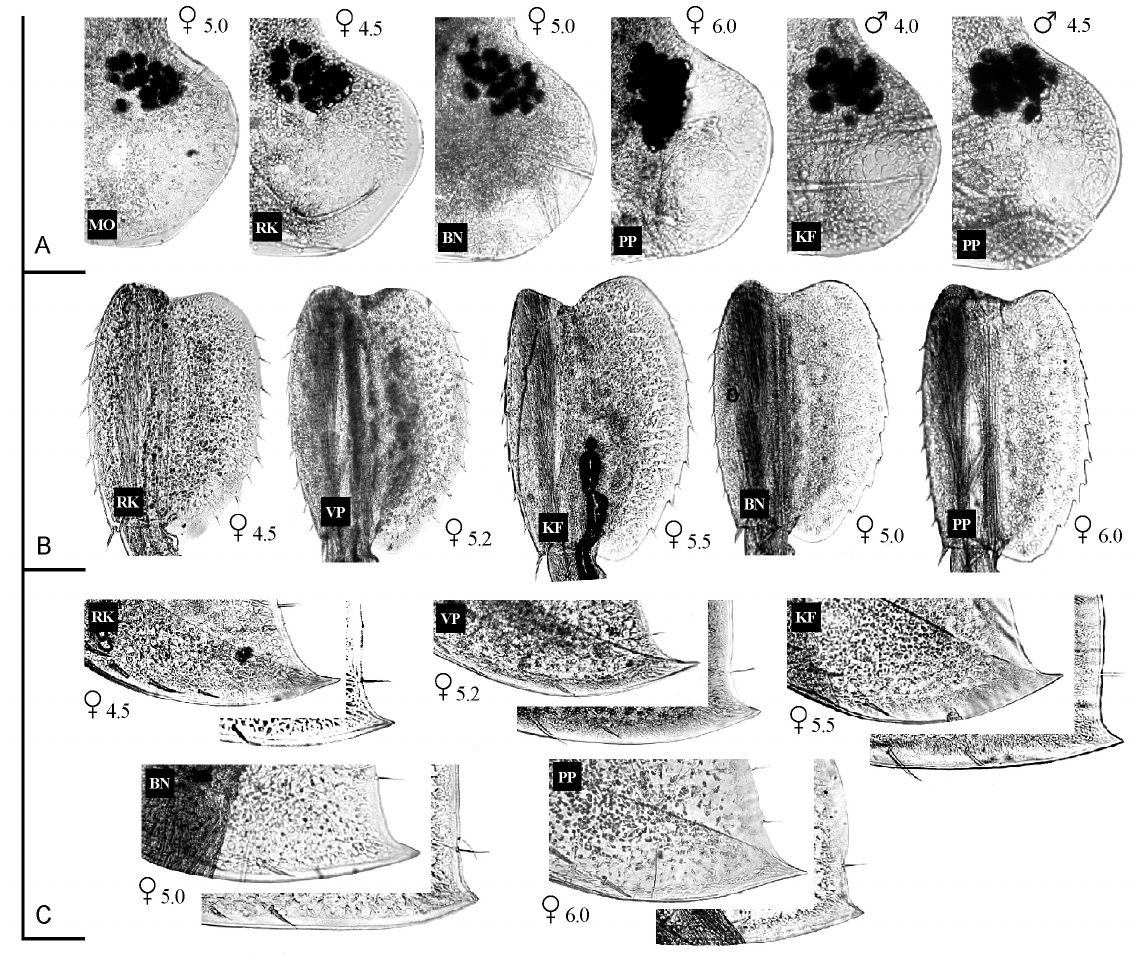
Fig. 9. Variability of ( A ) lateral cephalic lobe of Synurella ambulans (F. Müller, 1846) from different populations; ( B ) posterior margin of pereopod 7 basis; ( C ) epimera 2 and 3. (Digital